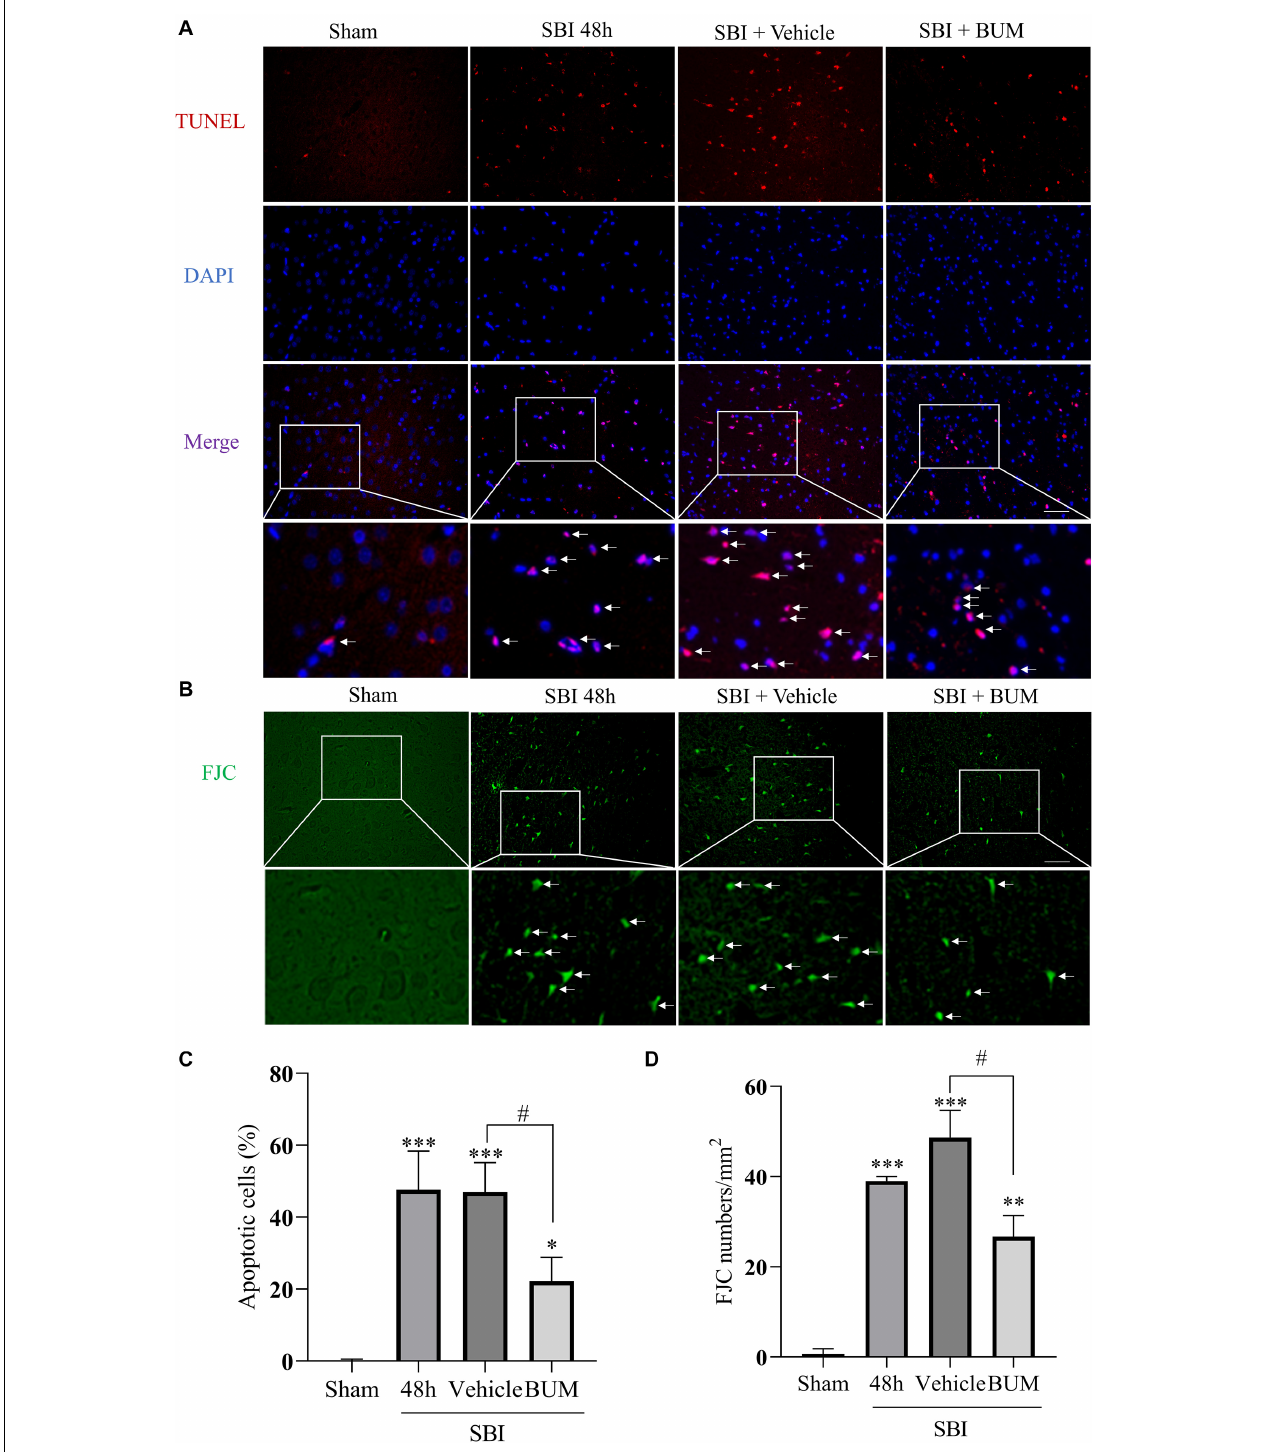
FIGURE 7 | Effects of BUM intervention on peripheral cortical cell degeneration and apoptosis 48 h after SBI. Neuronal apoptosis was assessed by TUNEL staining (A,C) . TUNEL (red) labeled apoptosis and DAPI (blue) labeled nuclei. FJC (green) staining detected cell denaturation (B,D) . Scale bar = 50 µ m. Statistical